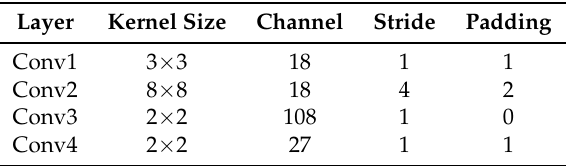
Figure 3. The architecture of the network. The parameter settings of the convolutional layers are shown in Table 1. The offset layer and the Rectified Linear Unit (ReLU) layer are implemented according to Equation (7). The norm layer normalizes the values to reduce the effect of changes in contrast. The layer of the clamp limits the maximum values to τ . Table 1. Detailed configurations of the convolutional layers. The first column is the name of each layer. The next four columns indicate the parameter settings of the corresponding